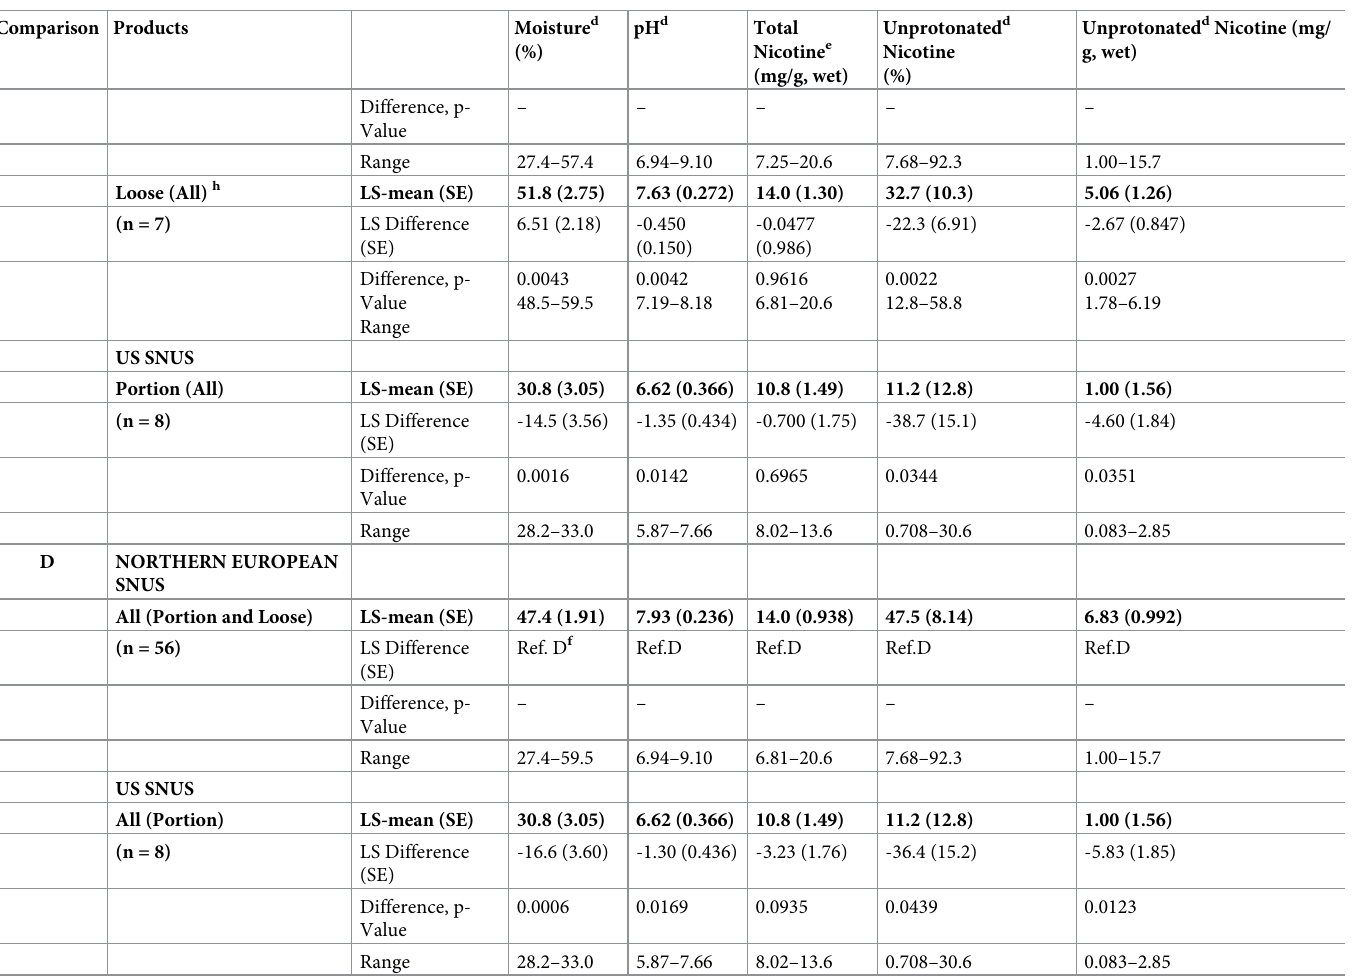
Table 1. Differences in means are evaluated in four comparisons with: A) Northern European portion standard snus; B) Northern European portion white snus; C) Northern European portion snus; and D) Northern European portion and loose